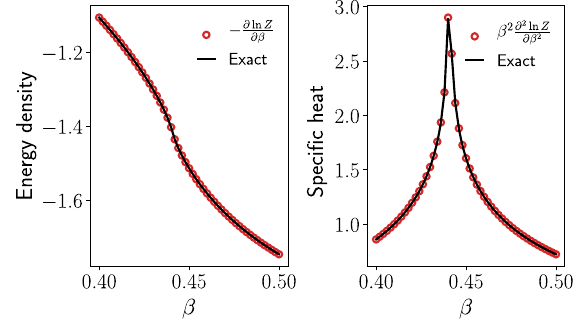
FIG. 3. Energy density and specific heat of the 2D Ising model. They are computed by taking the first- and second-order derivatives of the free energy obtained after 30 TRG iteration steps with a cutoff bond dimension χ ¼ 30 . Solid lines are exact solutions